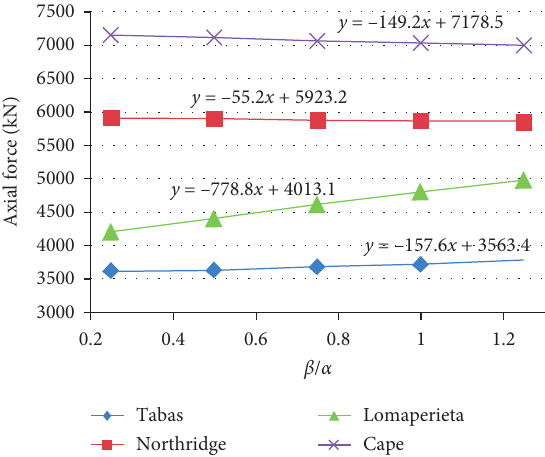
Figure 13: Maximum axial force of tunnel lining ( F ) at load combination 1 to